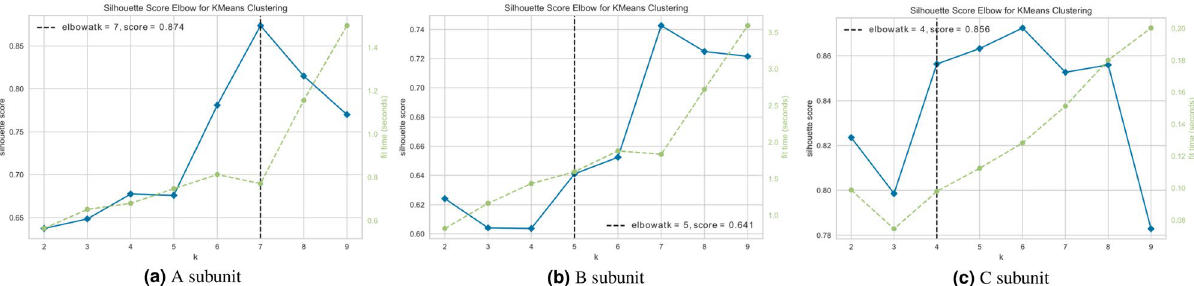
Figure 10. Silhouette score elbow curve showing optimal K for clustering. The silhouette score identifies the optimal value of clusters in K-means clustering. It ranges from − 1 to 1 with an aim to increase the intra-cluster similarity and decrease the inter-cluster similarity. A larger Silhouette value indicates that clusters are